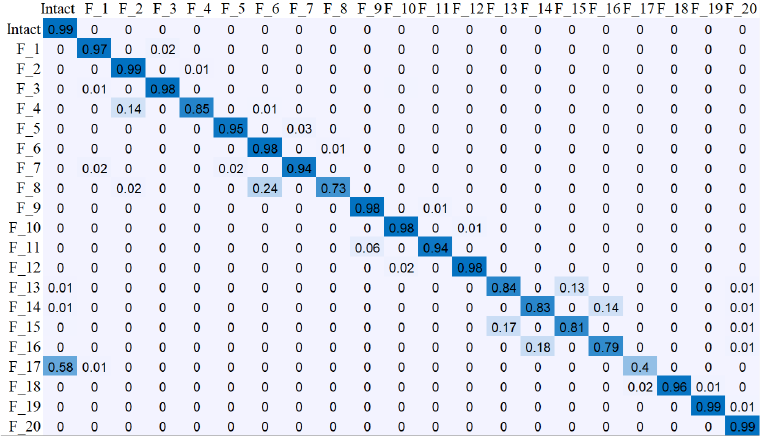
Figure 12. Failure detected location when there are 4 sensors at points 2, 4, 6, and 8 (Accuracy: 90.4%).